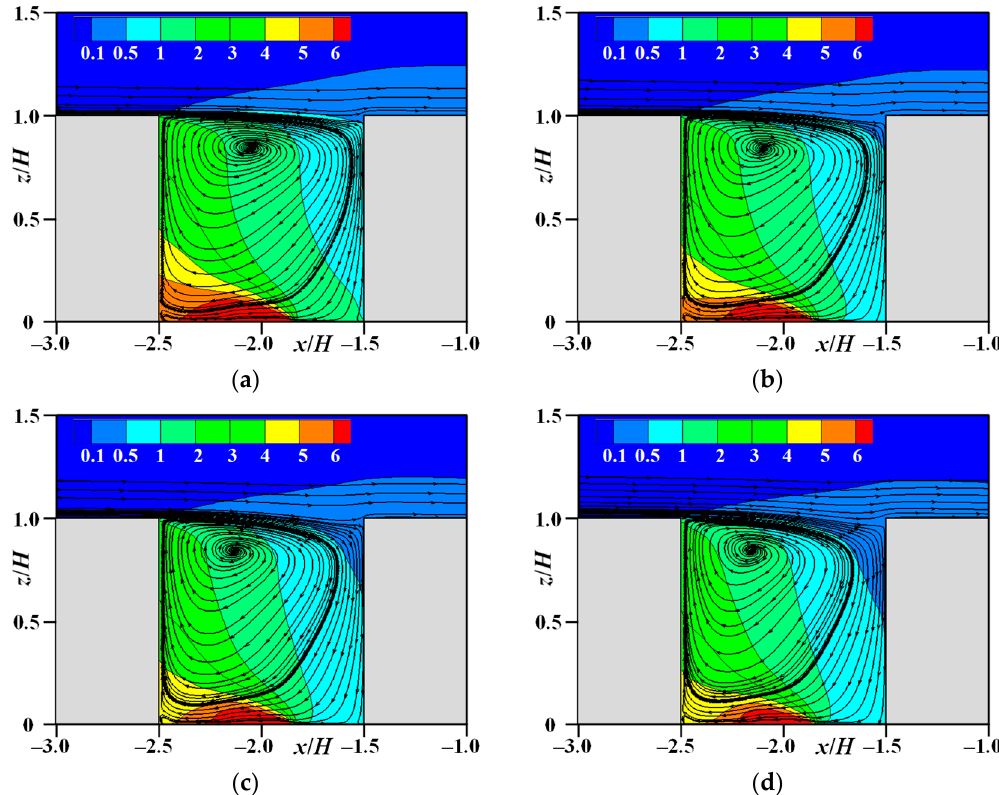
Figure 9. Mean streamlines and normalized concentration C / C * in the symmetry plane of pollutant source canyon (PSC) ( y = 0): ( a ) GH-30; ( b ) GH-40; ( c ) GH-50; ( d ) GH-60.